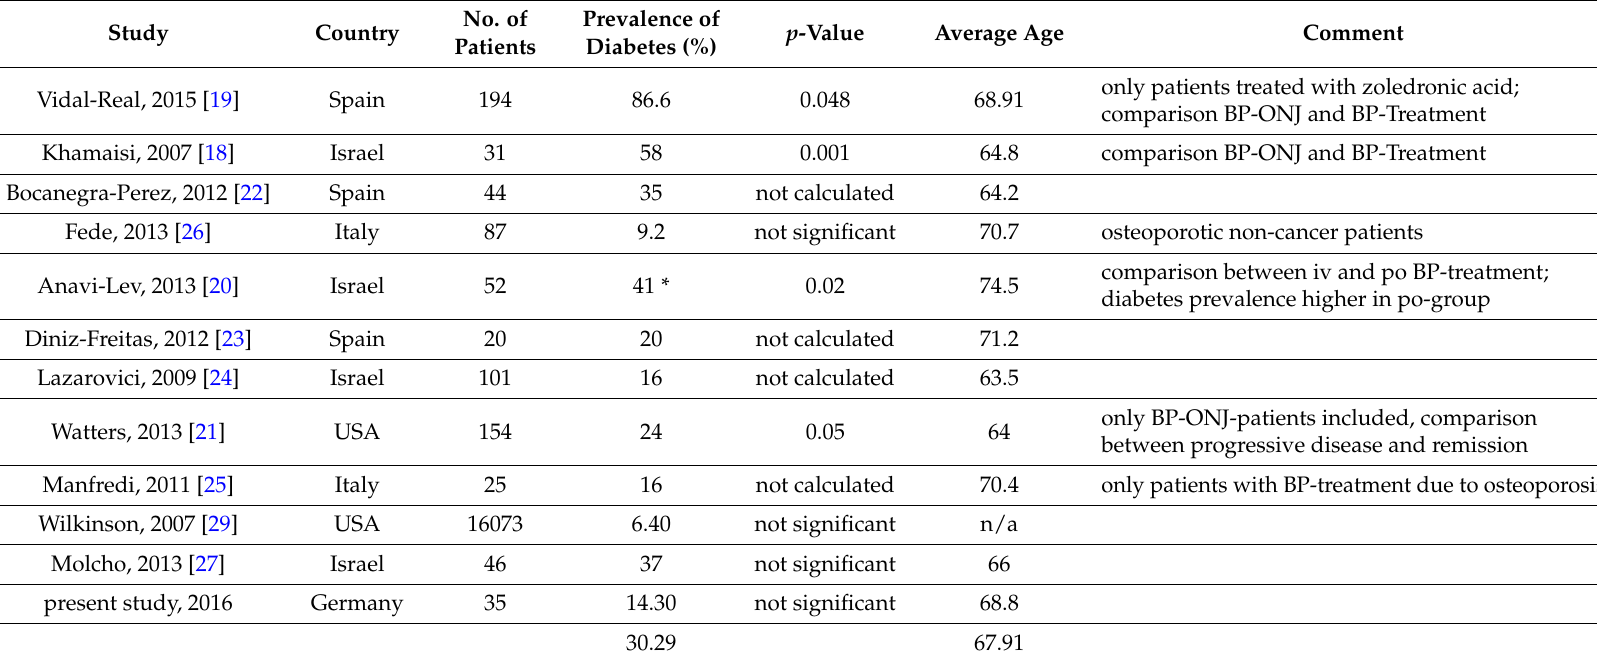
Table 2. Studies published concerning the relationship between diabetes and MR-ONJ. Where BP-ONJ refers to bisphosphonate-associated osteonecrosis of the jaws. Study